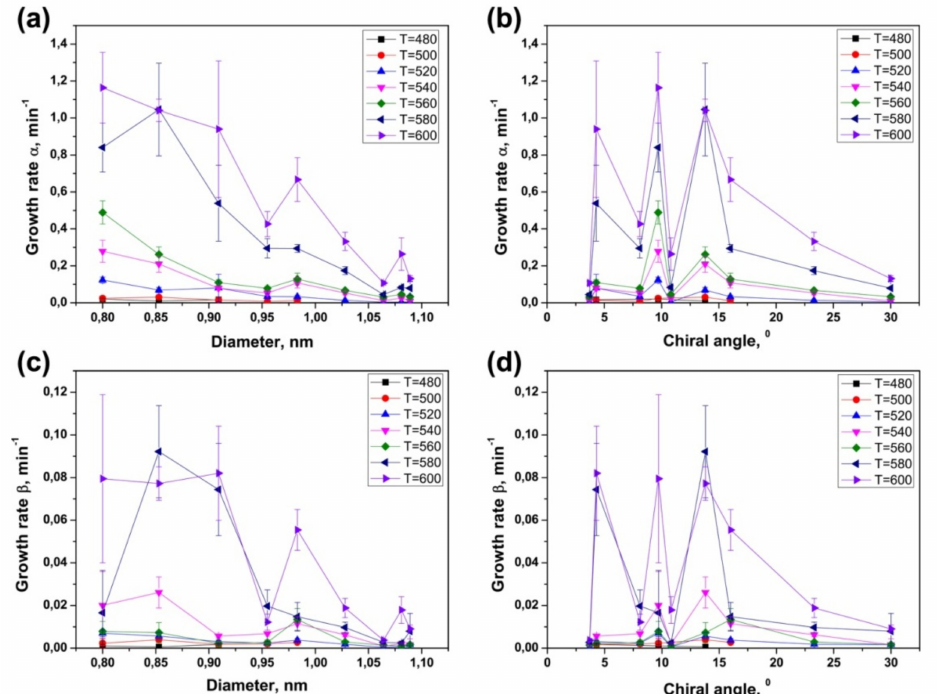
Figure 12. Growth rates α and β versus tube diameter ( a and c , respectively) and versus chiral angle ( b and d , respectively) for inner tubes with chiral vectors of (8,8), (12,3), (13,1), (9,6), (10,4), (11,2), (11,1), (9,3) and (9,2) formed upon in situ annealing of the nickelocene-filled SWCNTs at temperatures in a range from 480 to 600 ◦